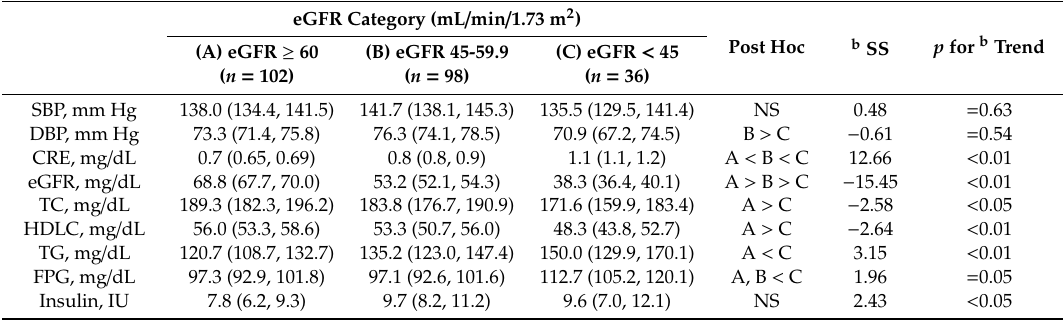
Table 4. Biochemical characteristics, adjusted for age and sex, and trends by eGFR